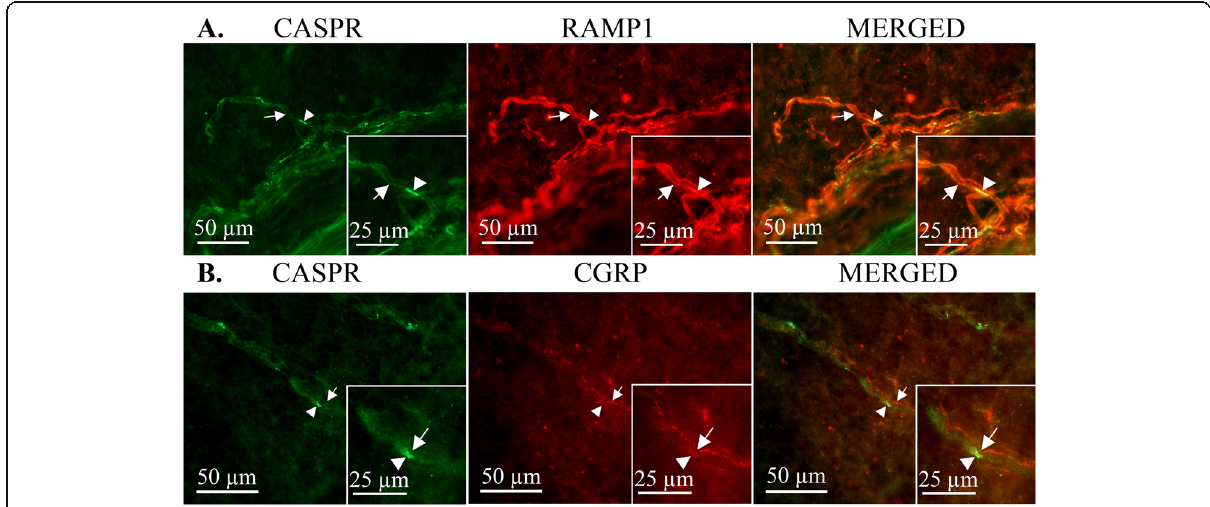
Fig. 6 Expression of RAMP1 and CGRP in relation to the node of Ranvier in rat dura mater spreads. RAMP1 ( a ) and CGRP ( b ) had similar localization at the node of Ranvier in the rat dura mater as for the TG. Top; CASPR (green, arrowhead), RAMP1 (red, arrow). Bottom; CASPR (green, arrowhead), CGRP (red,